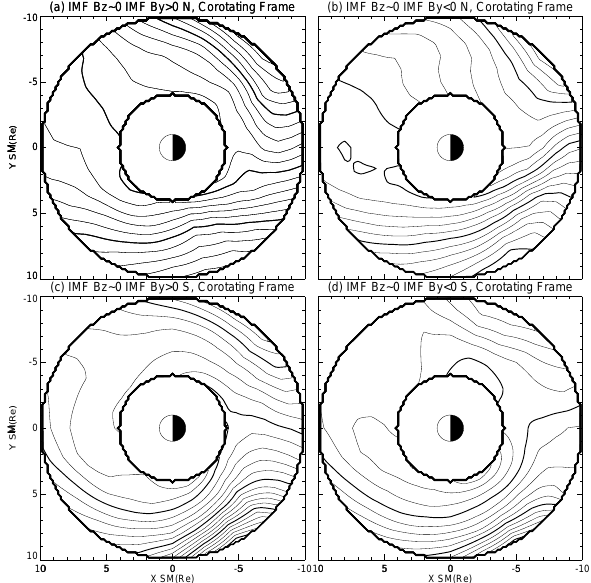
Fig. 3. Electric potential patterns at 4 <L< 10 for all MLT ranges. The conditions are IMF B Z > 0 and indicated as follows for each panel: (a) IMF B Y > 0 in the Northern Hemisphere, (b) IMF B Y < 0 in the Northern Hemisphere. (c) IMF B Y > 0 in the Southern Hemi- sphere, (d) IMF B Y < 0 in the Southern Hemisphere. The patterns are shown in the corotating frame. The contour intervals are 2kV and 10kV for thin and thick lines, respectively.